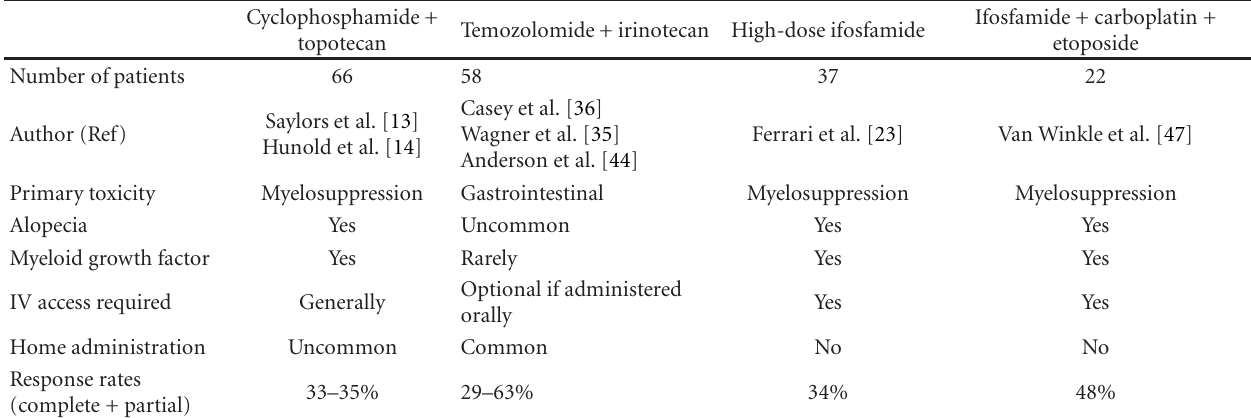
Table 3: Comparison of commonly used regimens for recurrent Ewing